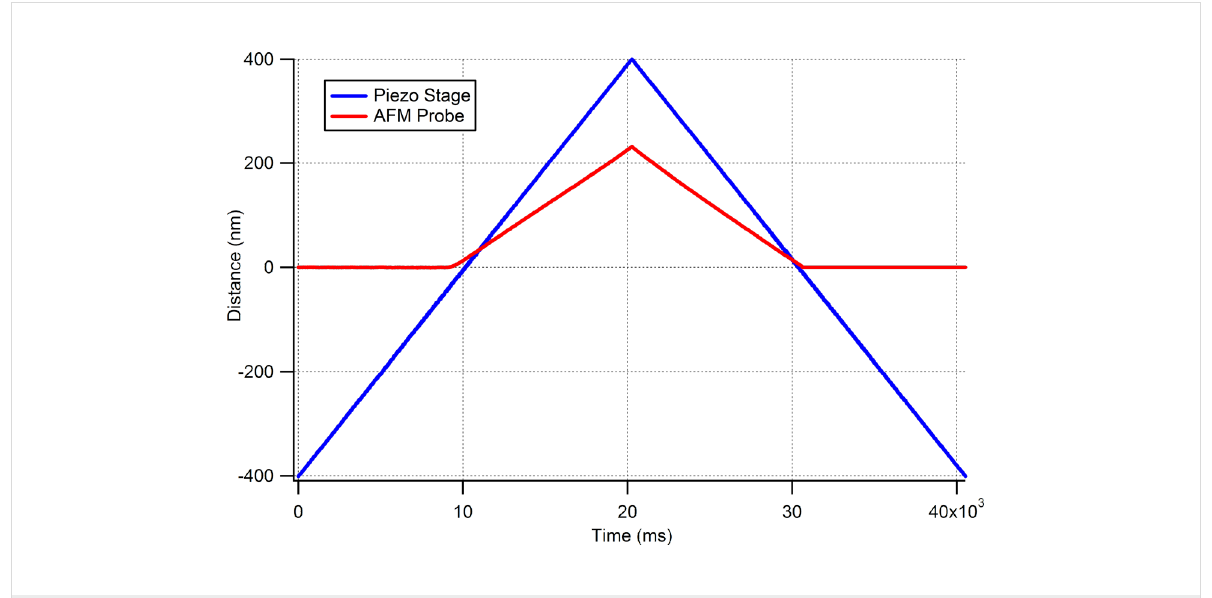
Figure 6: Experimental data showing AFM probe measurements on top of the diamond indenter for a fused silica sample.